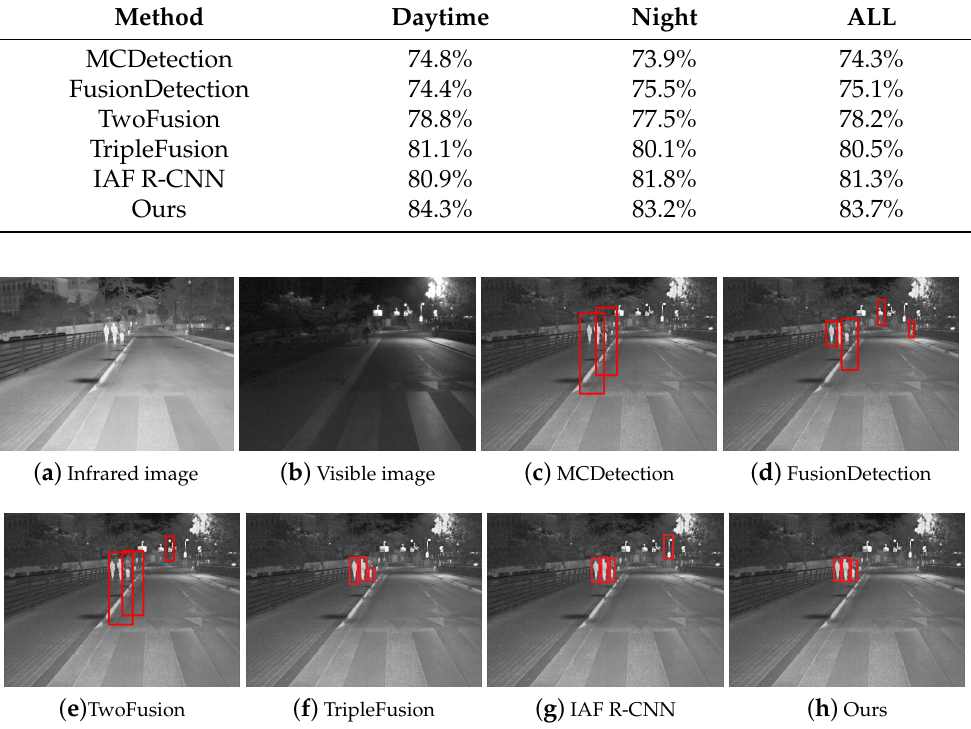
Figure 11. ( a – h ) The infrared and visible image detection results from six different detection methods. In order to better display the results, the detection results are shown on the fused